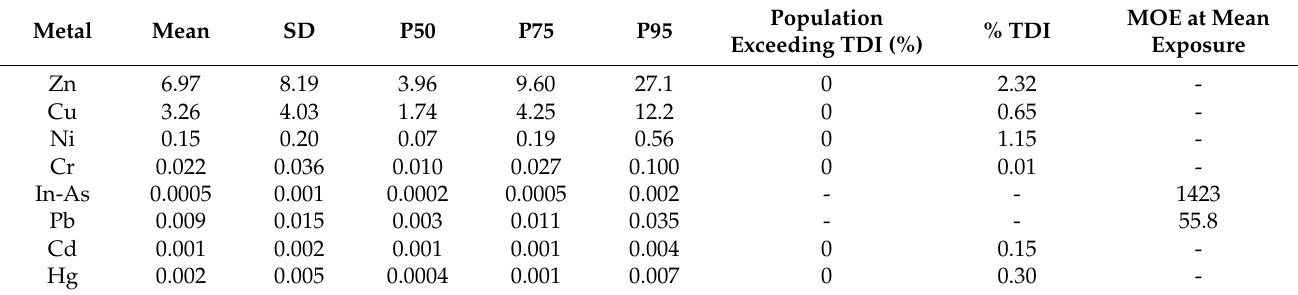
Table 4. Probabilistic exposures of metals in hepatopancreas and white meat of red mangrove crab for adults (mean, standard deviation (SD), and percentiles (Px)), % TDI calculated as (estimated mean exposure/TDI) × 100; mean, SD,